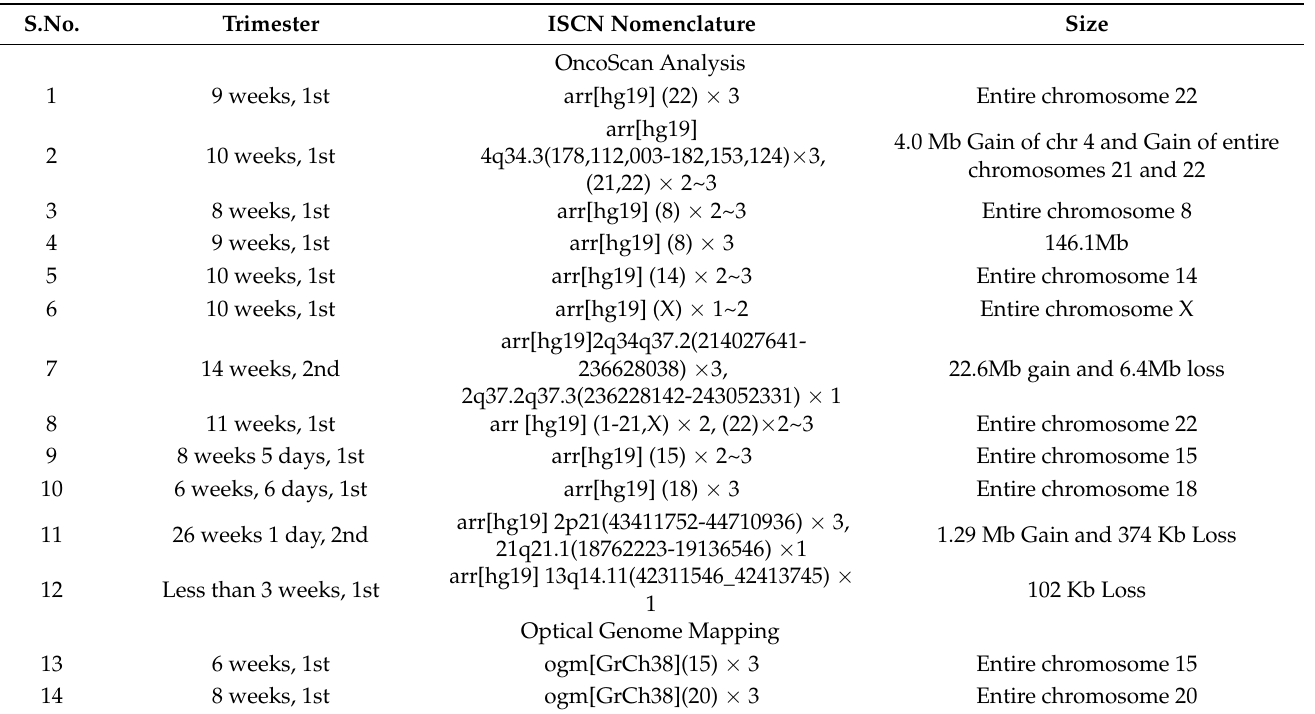
Table 2. Abnormal genetic aberrations detected with SNP microarray and optical genome mapping on the product of conception.